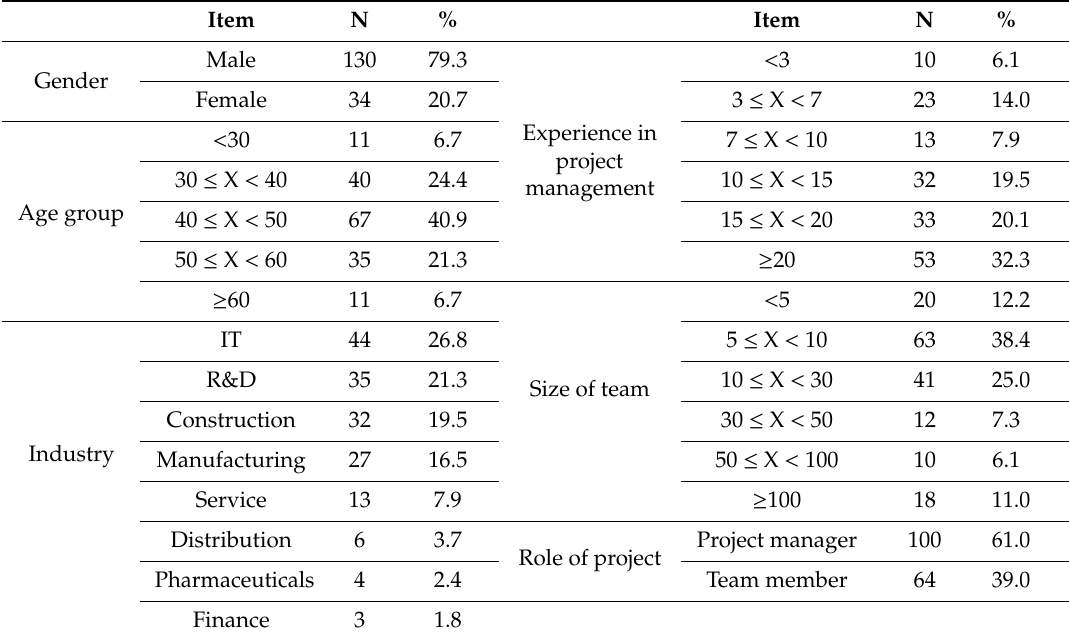
Table 2. Characteristics of